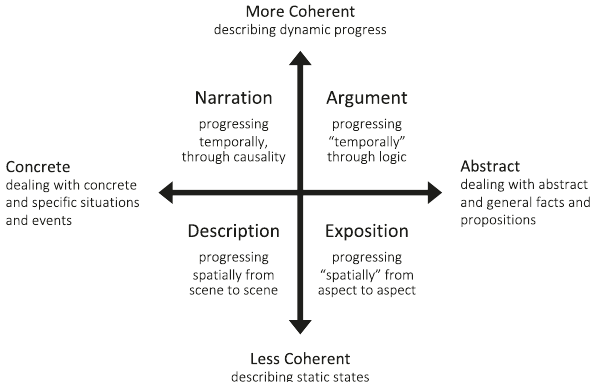
Fig. 1 Language as a window into the thought dichotomy. The fi